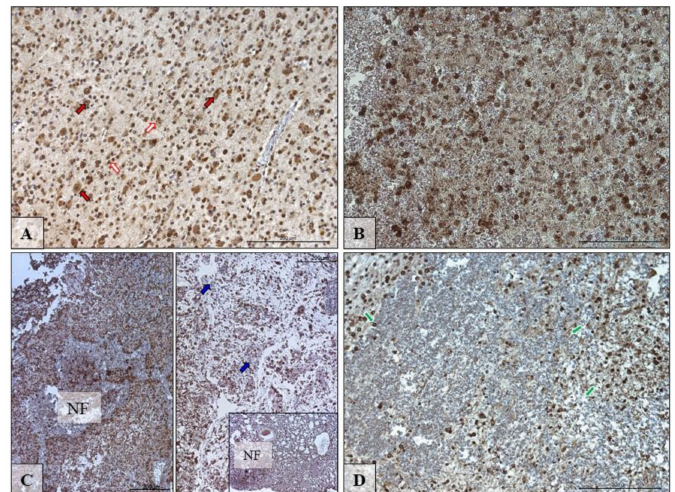
Figure 5. Representative microphotographs showing the protein expression of desaturase FADS2 in neurons and glia cells in the peritumoral area ( A ; red and white arrows) and in cells in the growing tumor area ( B ) necrotic foci (NF) ( C , D ; blue arrows) of brain tumors from patients diagnosed